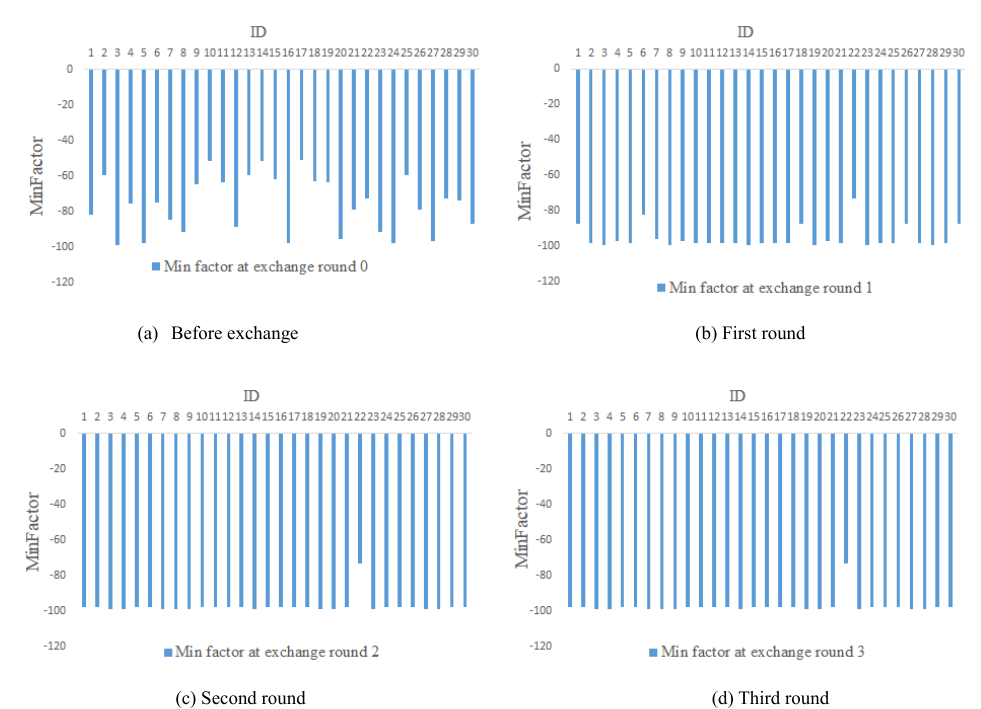
Figure 7. MinFactor at each vehicle in each exchange round in Scenario 1 regarding the pro- posed scheme.